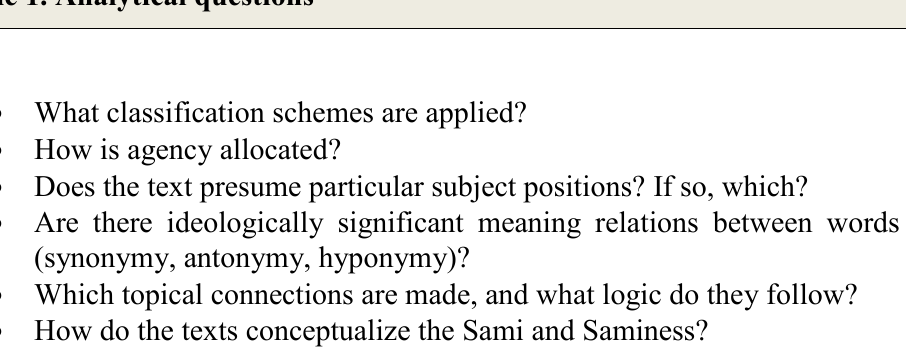
Table 1. Analytical